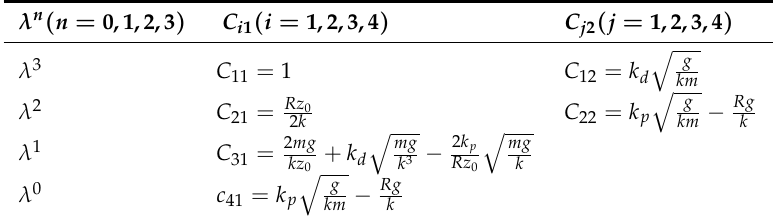
Table 1. Routh table of the characteristic equation of the matrix A